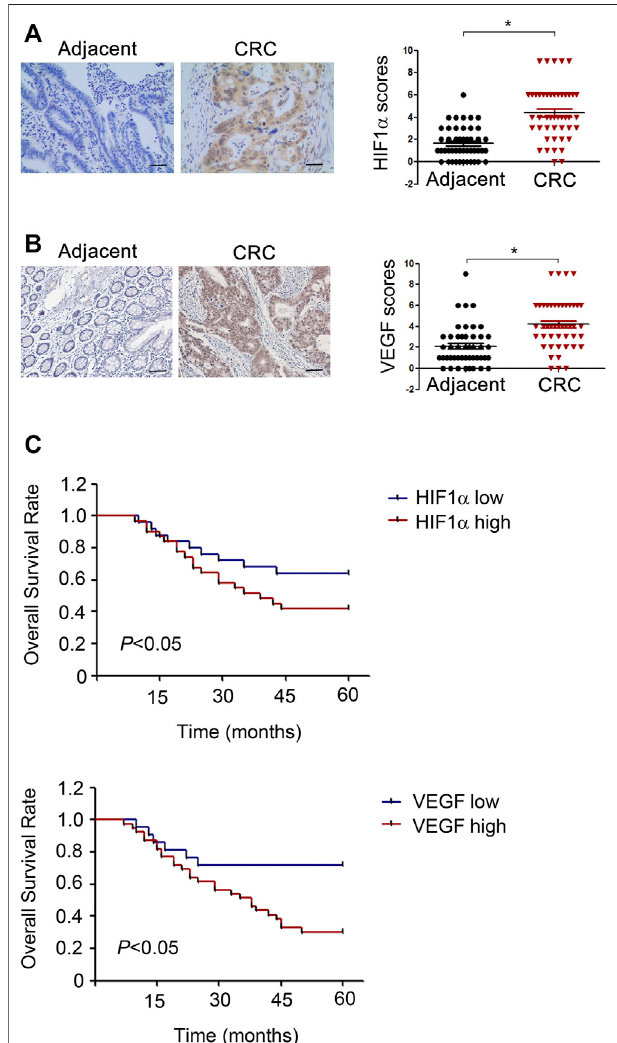
FIGURE 8 | HIF1 α and VEGF are high expressed in CRC patient tissues and predict poor prognosis. (A,B) Left, Representative IHC staining of HIF1 α in CRC tumor sample and normal tissue sample. Right, Scores for HIF1 α and VEGF staining in 60 pairs tumor tissue and adjacent normal tissue samples from CRC patients. (C) Univariate survival analysis of overall survival in CRC patients as determined by Kaplan-Meier plots estimates based on HIF1 α and VEGF protein